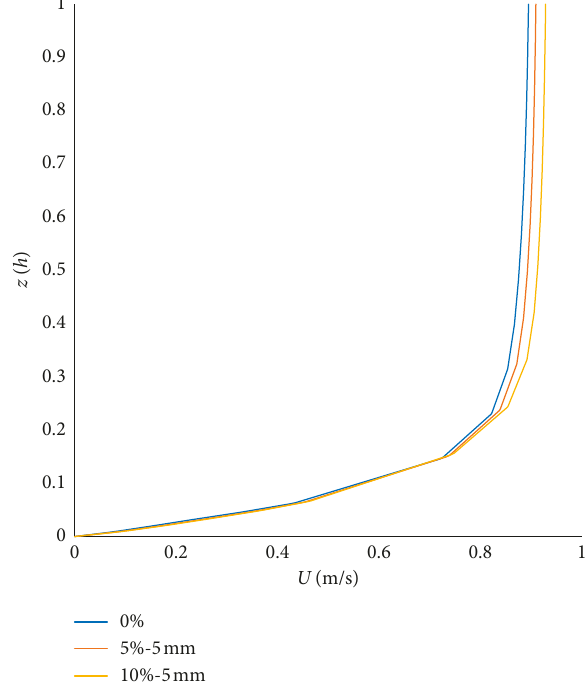
Figure 7: Steamwise velocity distribution with particle and without particle for the same inlet volume flow rate. The inlet velocity is 0.5665m/s. The velocity is measured 0.7m to the downstream from inlet of the